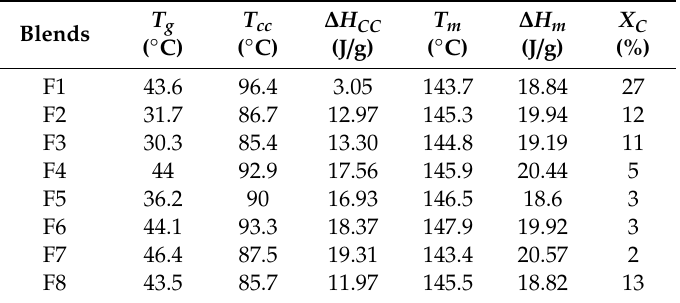
Table 4. Results of di ff erential scanning calorimetry analysis (first heating).